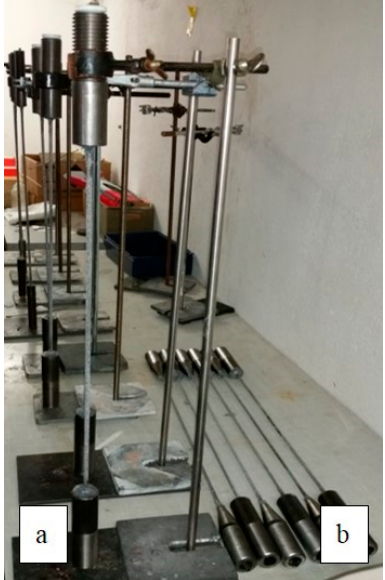
Figure 4. ( a ) Setup to cast epoxy grout anchorages; ( b ) Six CFRP specimens with testing anchors installed.